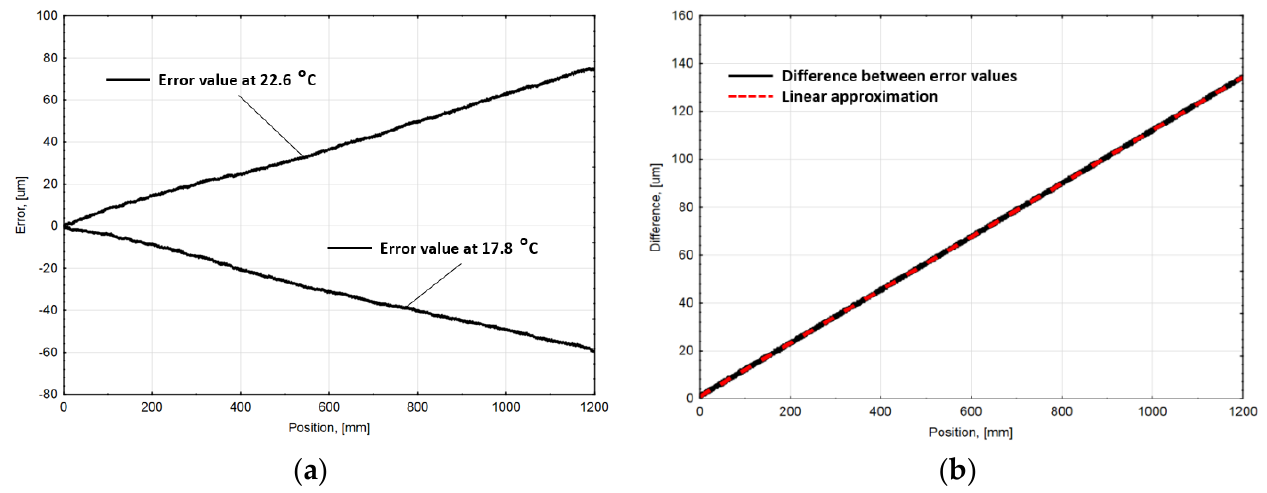
Figure 9. ( a ) Accuracy graphs of uncompensated linear encoder at 17.8 ◦ C and 22.6 ◦ C; ( b ) Differences between accuracy